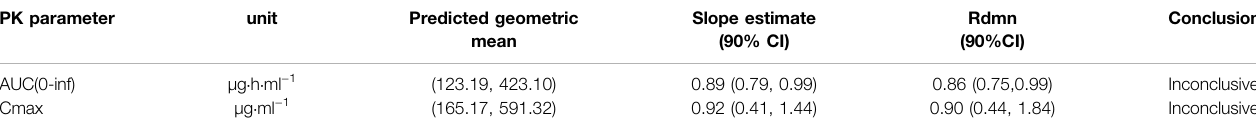
TABLE 2 | Summary of statistical analysis for dose-proportionality for 1.5, 23 and 46 mg kg − 1 MK-ASODN nanoliposomes in macaque monkeys. PK